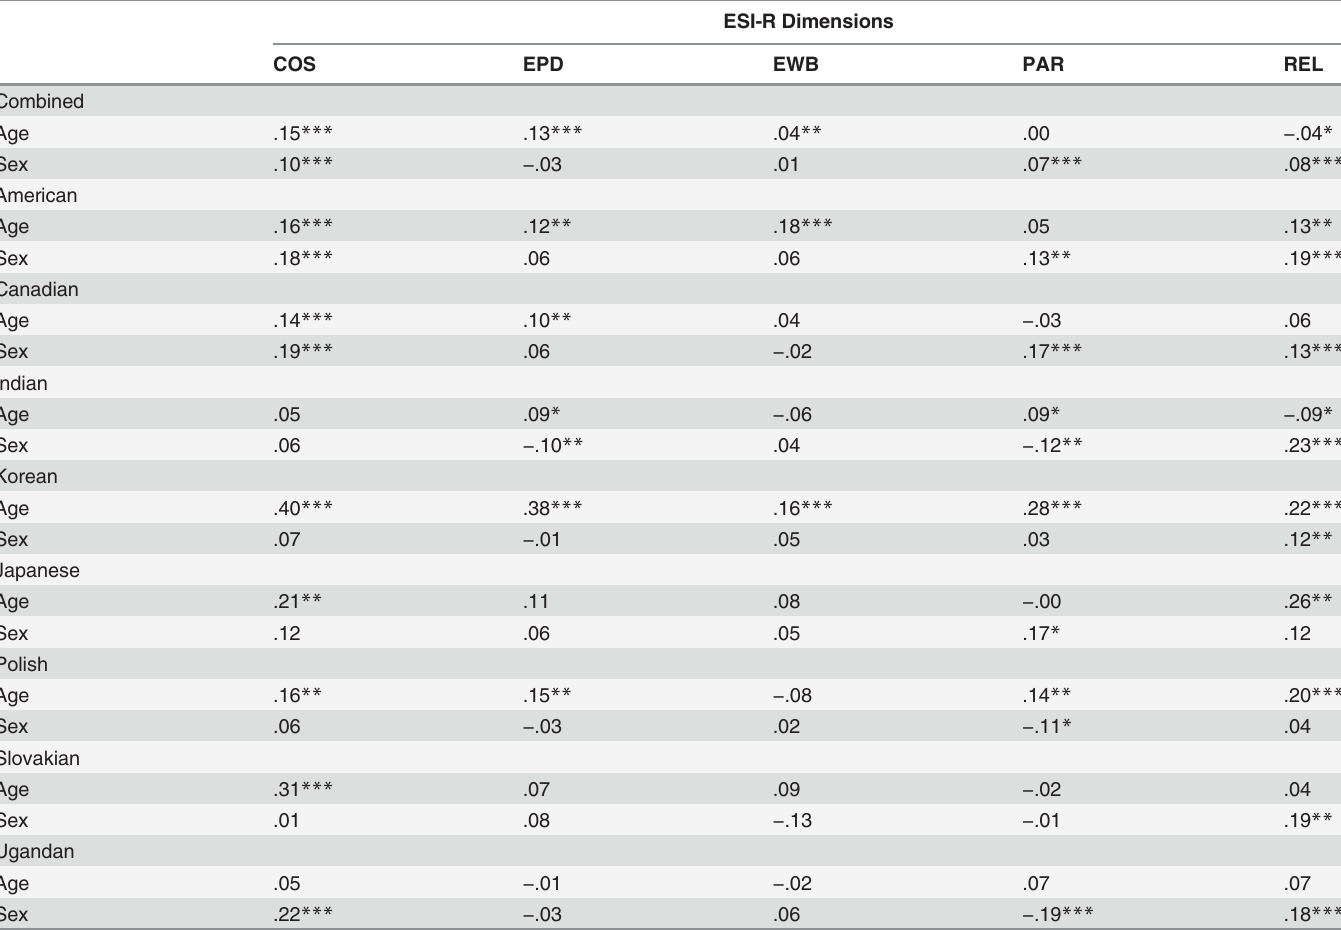
Table 7. Product-Moment Correlations Between ESI-R Dimensions and Demographic